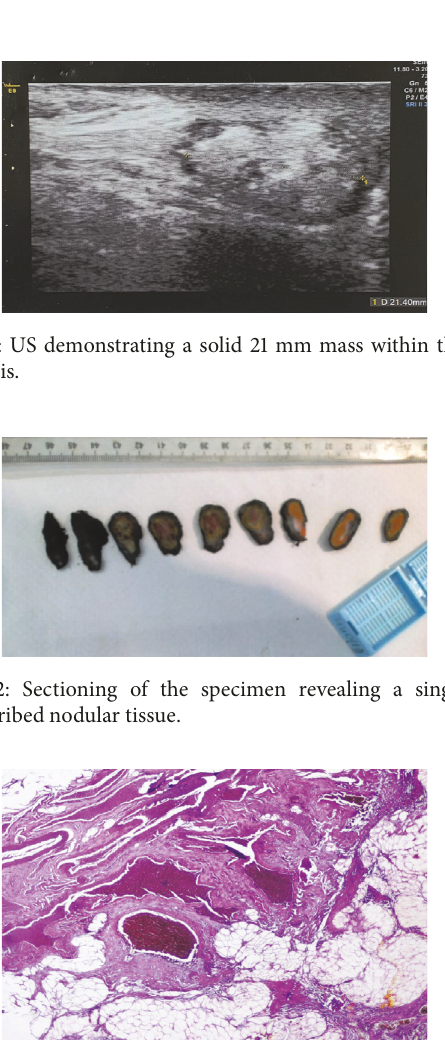
Figure 3: Microscopic examination showing a mature lobulated adipose tissue and numerous dilated and thicken walled blood